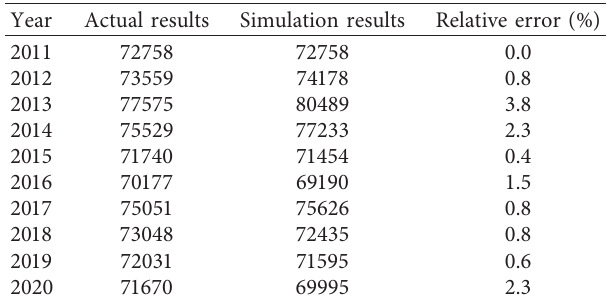
Table 4: Comparison of simulation results and actual results of GDP.